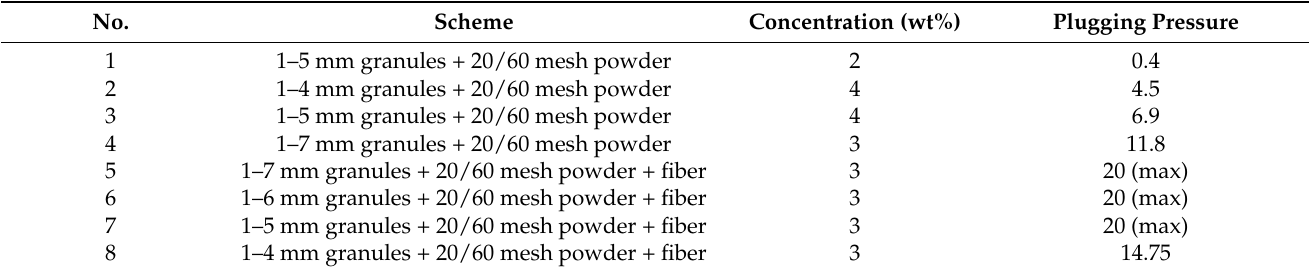
Table 2. Experimental results of different temporary plugging schemes.